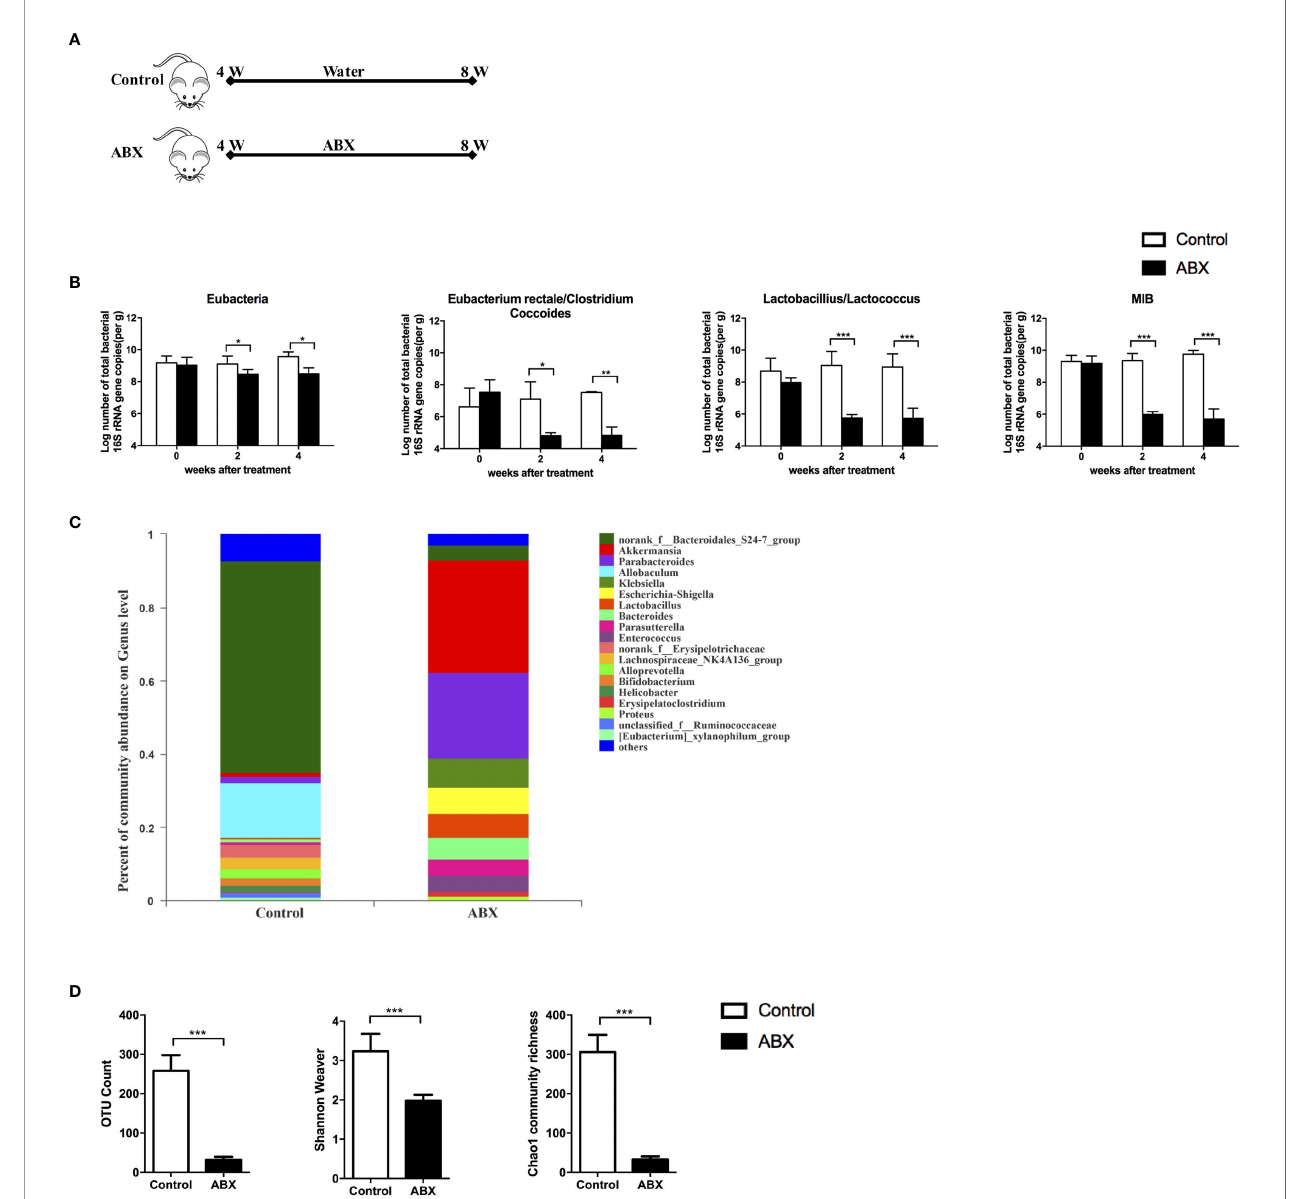
FIGURE 1 | Quantitative analysis of the gut microbiota after ABX therapy. (A) Schedule of the therapy in mice fed with water or ABX for 4 weeks. (B) The abundance of speci fi c commensal bacterial groups in fecal pellets measured using qPCR after ABX therapy. 16S rRNA sequencing from fecal pellets after ABX therapy. The composition of gut microbiota at genus-level (C) , the abundance and diversity of the gut microbiota (D) were assessed. n=10/group, *P < 0.05, **P < 0.01, ***P <